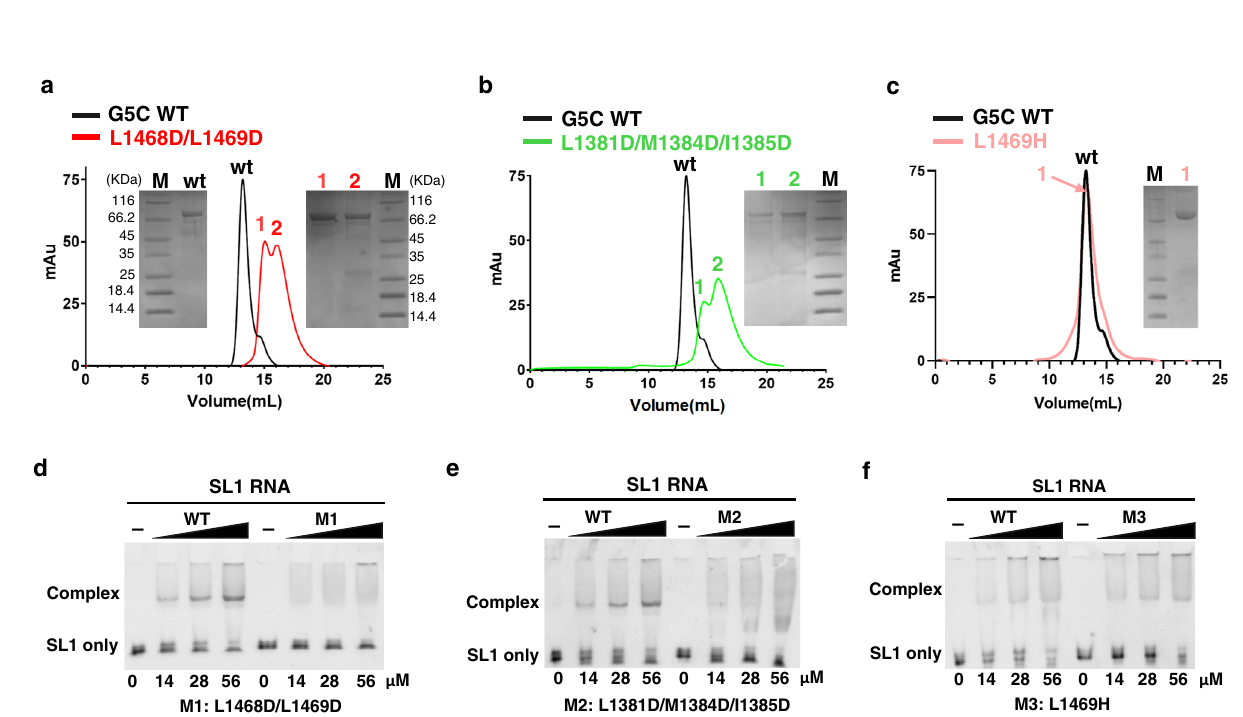
Fig. 3 | Structure of the G5C decamer. a Overall structure of the G5C decamer, with each molecule colored differently. The distance between the two parallel pentagonplanesis~177Å.Thesidelengthsoftheouterandinnerpentagonsare83 and32Å,respectively. b Projectionoftwopentagonplanes,witharotationangleof 36°. c Structure of the G5C pentamer region, with the molecules colored as in ( a ).